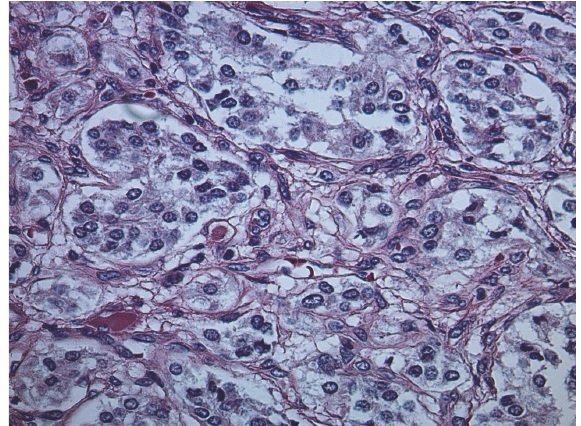
Figure 3: Pathology from left adrenal. H&E (400x). High power depictsampleandfinelygranulareosinophiliccytoplasm.Thenuclei exhibit typical “salt and pepper” chromatin, characteristic of all neuroendocrine tumors. Nuclei are round to oval and uniform without significant pleomorphism or mitotic activity. Nucleoli are inconspicuous.